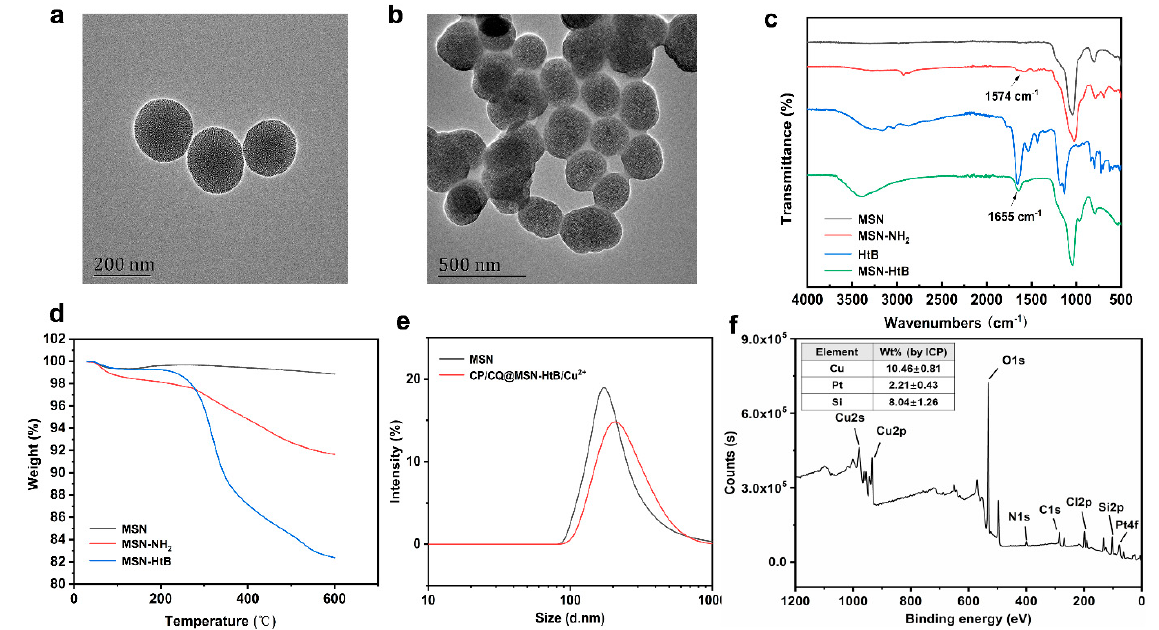
Figure 1. ( a ) TEM images of MSNs and ( b ) CP/CQ@MSN − HtB/Cu 2+ . ( c ) IR spectra of functionalized MSNs and the HtB peptide. ( d ) TGA curves. ( e ) Particle sizes of MSN and CP/CQ@MSN − HtB/Cu 2+ NPs. ( f ) Survey XPS spectrum and ICP data of CP/CQ@MSN − HtB/Cu 2+ .